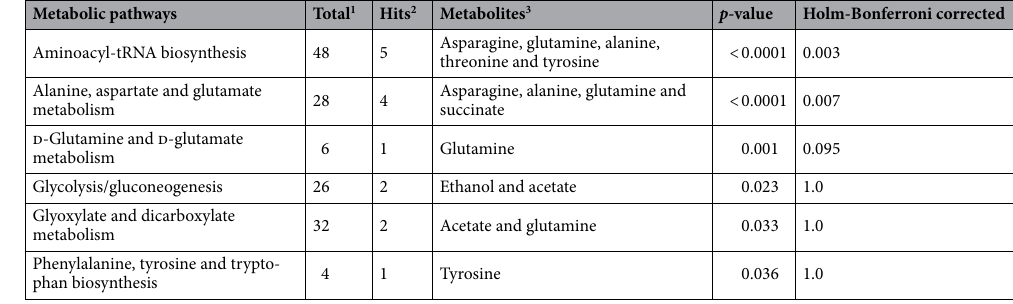
Table 3. Metabolic pathways influenced by significative metabolites in hyperketonemic ewes (Group HYK; n = 18; BHB ≥ 0.80 mmol/L) with their p -value. 1 Total number of metabolites in the pathway based on the Kyoto Encyclopedia of Genes and Genomes (KEGG) database. 2 Number of metabolites influenced the pathways in this experiment. 3 Metabolites identify by KEGG